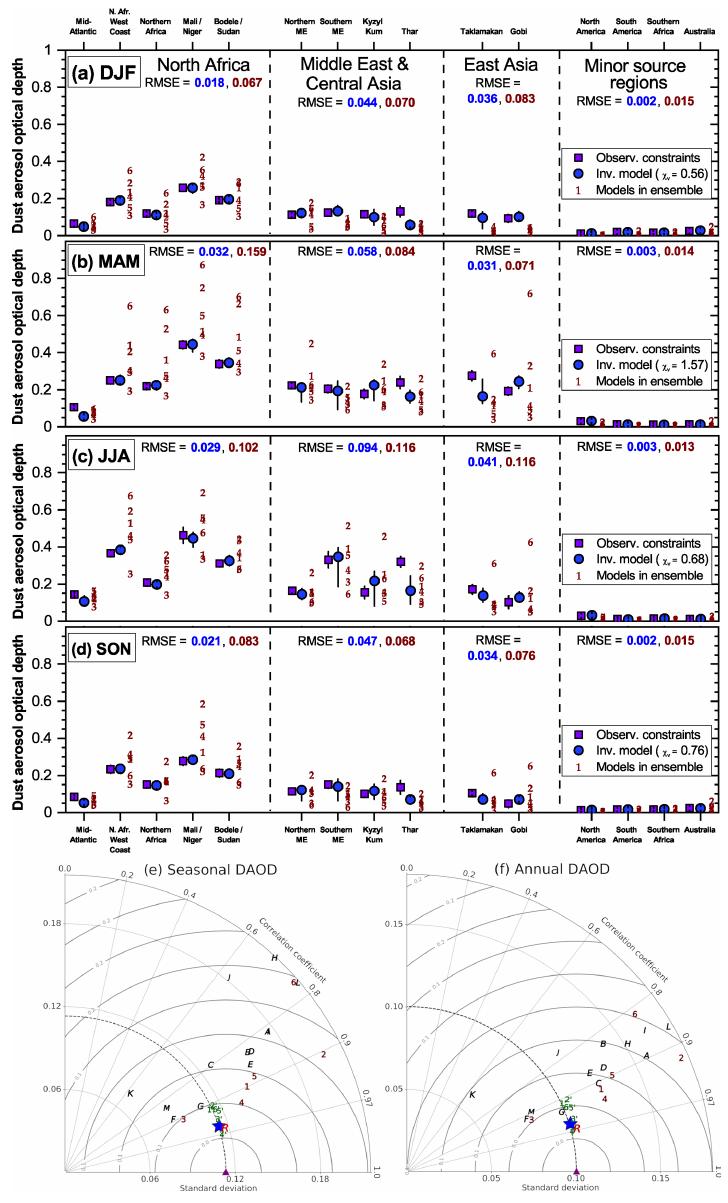
Figure 3. Assessment of the effectiveness of the inverse model in reducing errors against observationally informed constraints on regional dust aerosol optical depth (DAOD). (a–d) Comparisons of the 15 observational constraints on regional DAOD (purple squares) against the inverse model results (blue circles) and the models in our ensemble (brown numbers; 1 – CESM, 2 – IMPACT, 3 – GISS ModelE2.1, 4 – GEOS/GOCART, 5 – MONARCH, 6 – INCA) for each of the four seasons. Results are grouped by the major source region nearest to each of the observed regions. Also listed are the root mean square errors for each regional group for both the inverse model and model ensemble results, as well as the reduced chi-squared metric ( χ v ) for the comparisons of the inverse model results against all 15 DAOD constraints. Error bars denote 1 standard error. (e) Taylor diagram summarizing the statistics of the comparison against the seasonally averaged regional DAOD constraints for the different models (Taylor, 2001). The different symbols represent the measurements (purple triangle), the 13 AeroCom models (black letters; A – CAM, B – GISS ModelE, C – GOCART, D – SPRINTARS, E – MATCH, F – MOZGN, G – UMI, H – LOA, I – UIO_CTM, J – LSCE, K – ECHAM5, L – MIRAGE, M – TM5), the MERRA-2 dust product (red R ), the six models in the model ensemble (brown numbers, as for panels a–d ), the six improved model results (green numbers with a prime), and the inverse model results (blue star). The horizontal axis shows the standard deviation of the dataset or model prediction, the curved axis shows the correlation, and the grey half-circles denote the centered root mean square difference between the observations and the model predictions. As such, the distance between a model and the observations is a measure of the model’s ability to reproduce the spatiotemporal variability in the observations; Taylor diagrams do not capture biases between model predictions and observations. (f) Same as panel (e) , except showing a comparison against the annually averaged regional DAOD